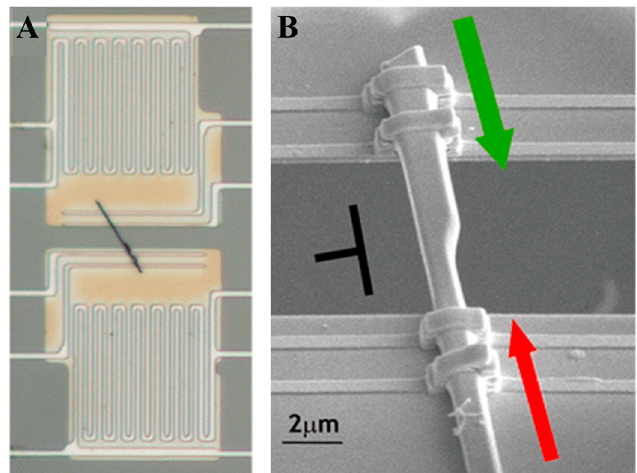
Figure 8. ( A ) Optical microscope image of a VO 2 beam suspended between two pads for thermal conductance measurement. ( B ) SEM image of an asymmetric VO 2 beam. Reprinted with permission from ACS Publications.